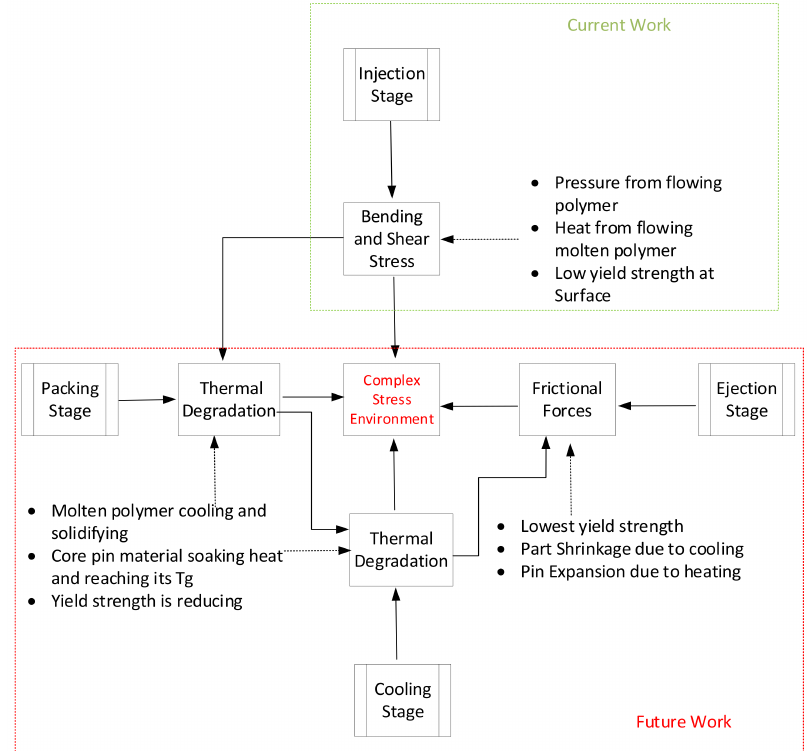
Figure 32. Potential causes of failure of core